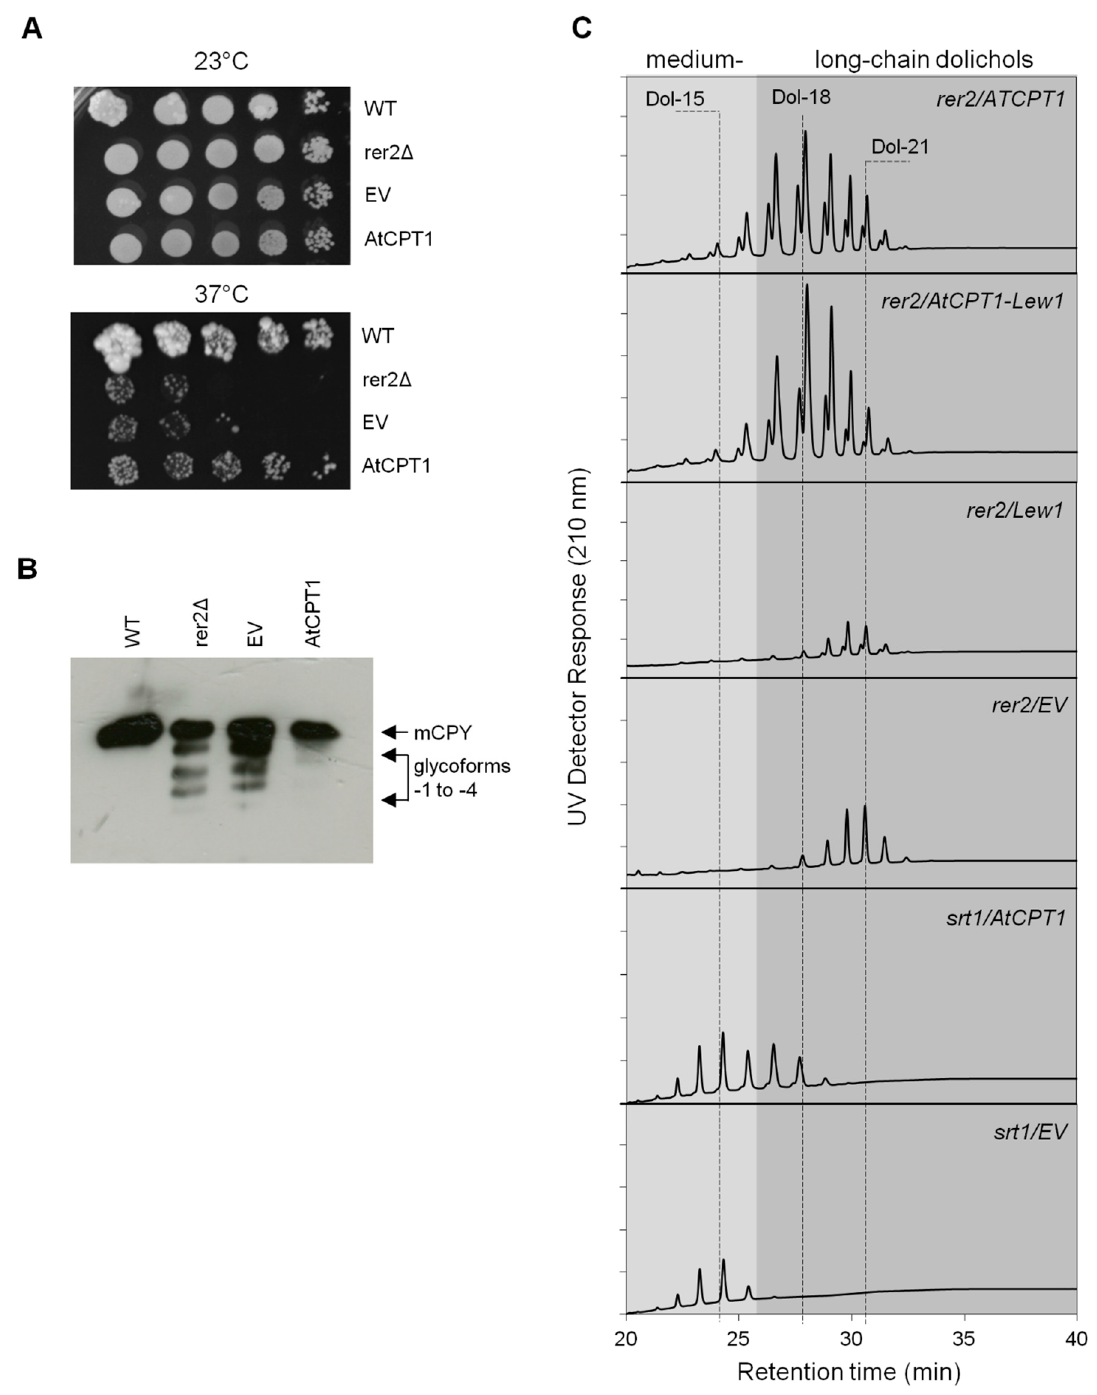
Figure 5. Analysis of enzymatic activity of AtCPT1 in the S. cerevisiae CPT mutants, rer2 Δ or srt1 Δ . ( A ) Expression of AtCPT1 in rer2 Δ mutant complements defects in growth. rer2 Δ cells were transformed with the empty plasmid pYES-DEST52 and AtCPT1 construct, respectively. Serially diluted yeast cultures were plated on solid YP-2% galactose medium and cultured for five days at 23 or 37 °C. ( B ) AtCPT1 expression in rer2 Δ yeast strain restores glycosylation status of carboxypeptidase Y (CPY). Protein extracts from yeast transformants were separated by SDS-PAGE and analyzed by Western blot with anti-CPY antibody. The positions of mature CPY (mCPY) and hypoglycosylated glycoforms lacking between one and four N -linked glycans (–1 to –4) are indicated. ( C ) Polyisoprenoid profiles of rer2 Δ or srt1 Δ yeast mutants transformed with empty plasmid, AtCPT1, AtCPT1/Lew1 and Lew1 , respectively. Presented are representative HPLC/UV chromatograms.